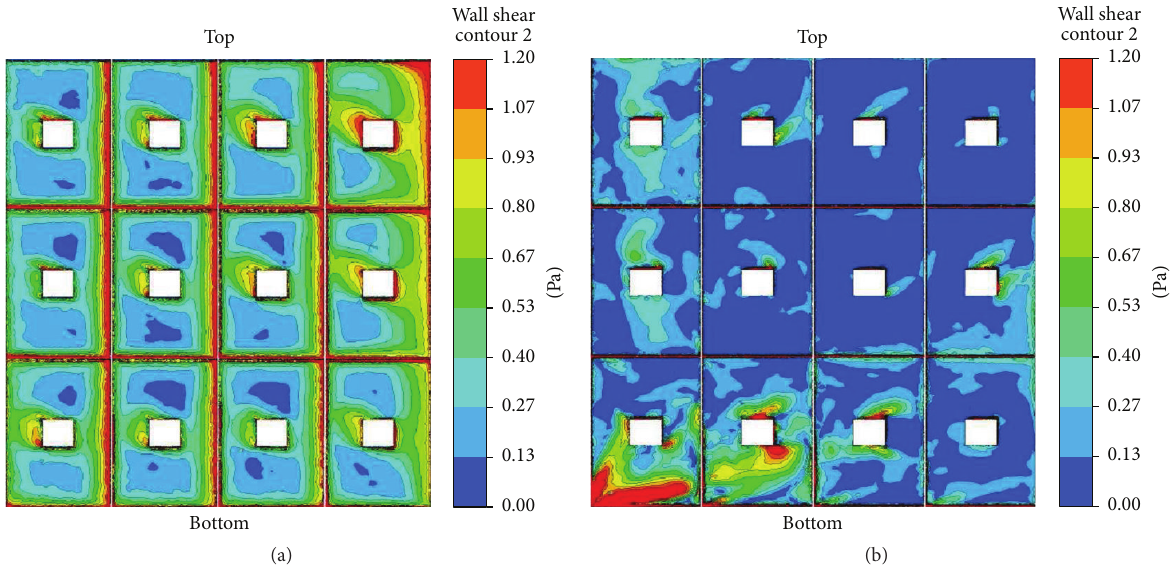
Figure 20: Wall shear stress (N/m 2 ) contours at panels with holes with 120.0 ∘ approach angle and maximum upwind velocity: (a) upwind side and (b) downwind side. Arrows show the wind direction (azimuthal